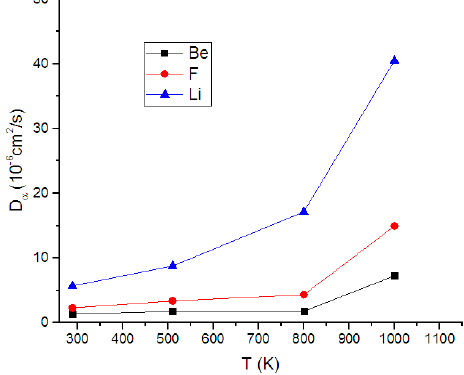
Fig. 4. Diffusion coefficients of Li2+, F− and Be2+ in liquid molten salt LiF-BeF 2